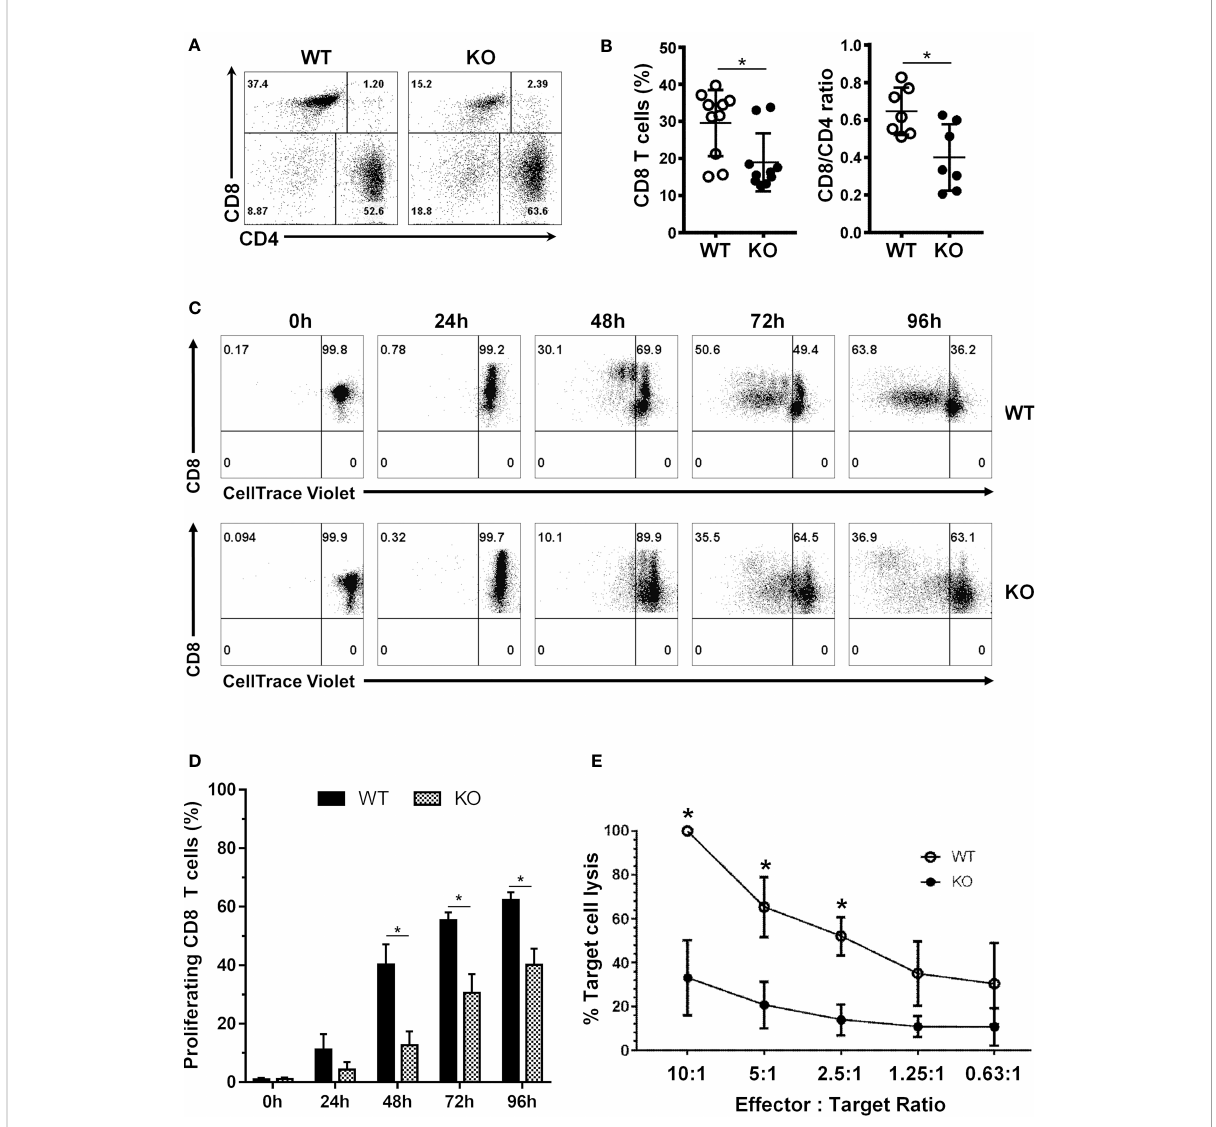
FIGURE 1 SRSF1 is necessary for CD8 T cell homeostasis, proliferation and cytotoxic function. (A) Flow cytometry dot plots show ex vivo frequencies of CD8 and CD4 T cells from the spleens of WT and Srsf1 -cKO (KO) mice (B) Graphs show percentage of CD8 T cells and CD8/CD4 ratio (n=7). (C) Flow cytometry dot plots and histograms show proliferation of stimulated CD8 T cells from WT and Srsf1 -cKO mice (D) Graphs show percentage of proliferated cells (n=5) (E) Graph shows percentage of target cell lysis after coculture with CD8 T cells from WT (n=3) or Srsf1 - cKO mice (n=4), at different effector:target ratios. Graphs show mean ± SEM. p-values